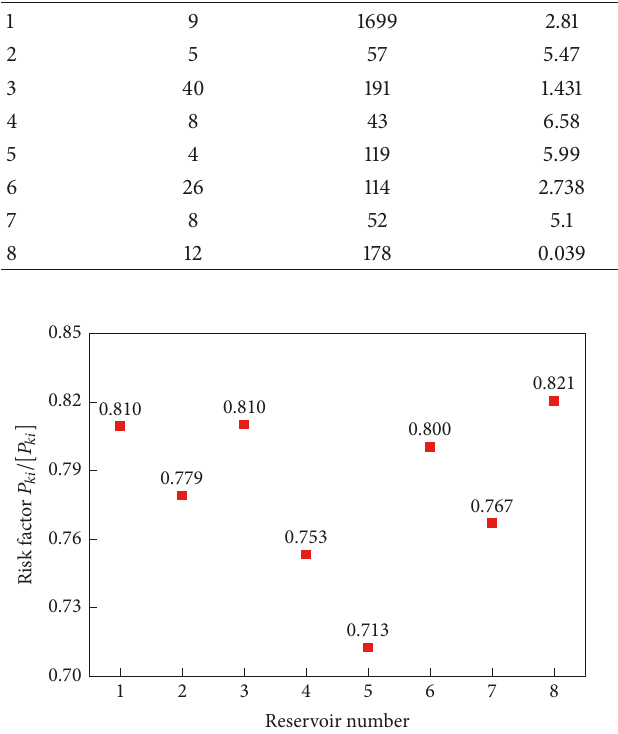
Figure 2: Risk factors of each reservoir for the base case of the Shenhua CCS